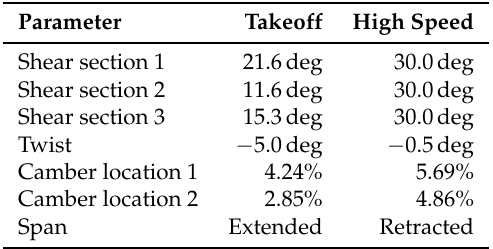
Figure 3. For the sake of brevity, the actuation moment required for shear morphing is only shown for shear section 1 and the actuation moment required for camber morphing is only shown for the leading edge (0%–50% chord) about the mid chord at the wing root. Similar conclusions can be drawn for the other shear sections and camber locations. Table 2. Optimised morphing parameters.